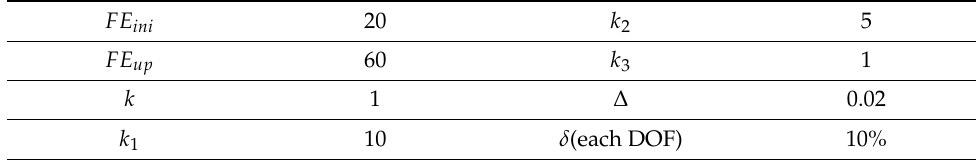
Table 1. Parameters settings in the optimisation